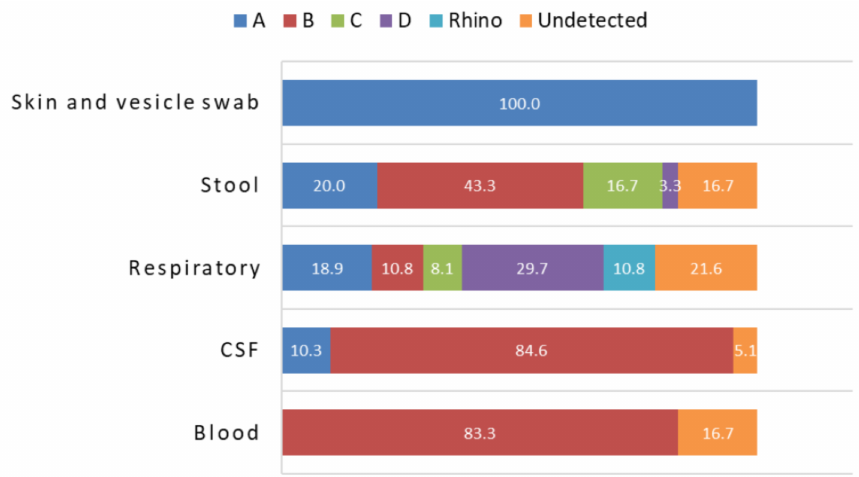
Figure 1. Distribution of EV species by sample type in 112 clinical samples from England determined by NGS